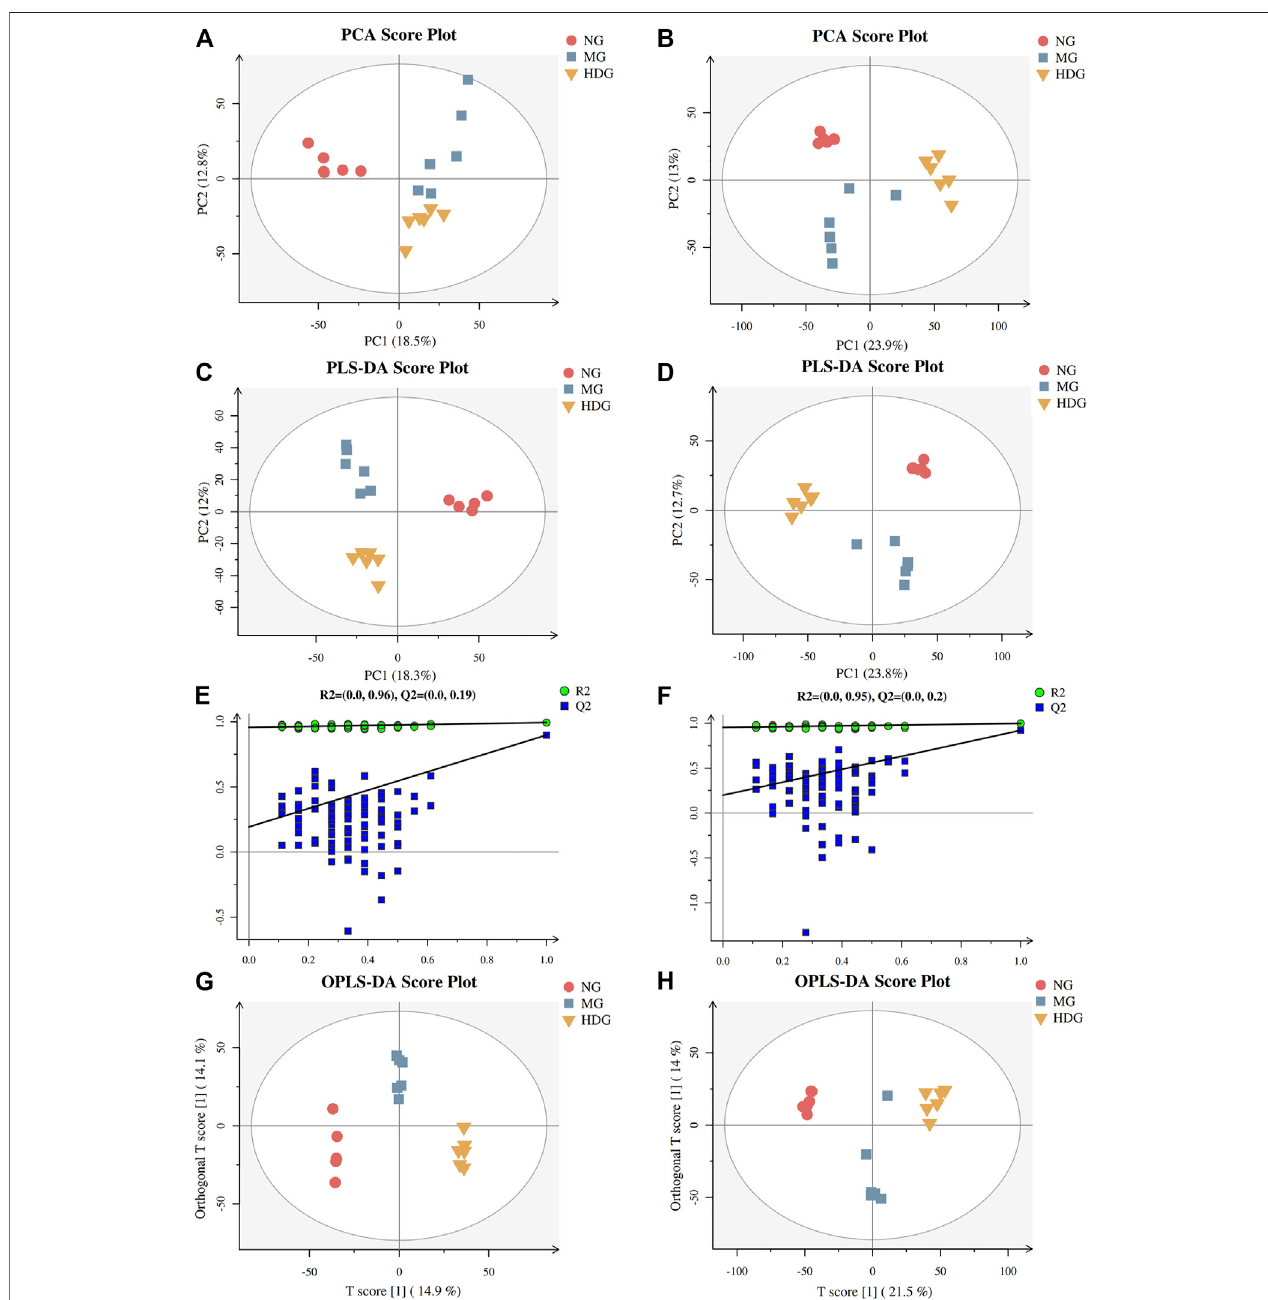
FIGURE 6 | The results of multivariate statistical analysis. The PCA score graph in positive (A) and negative (B) ion mode. The PLS-DA score graph in positive (C) and negative (D) ion mode. Permutations graph in positive (E) and negative (F) ion mode. The OPLS-DA score graph in positive (G) and negative (H) ion mode.